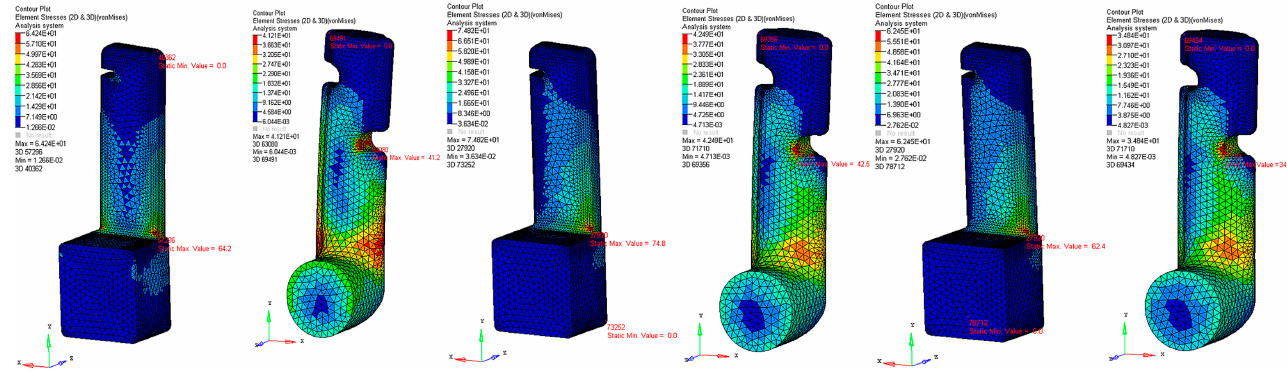
Figure 15. Pair in the left shows stress according to von Mises hypothesis in MPa, load LC_A1, pair in the middle shows stress under load LC_B1 and pair on the right is LC_C1 load.